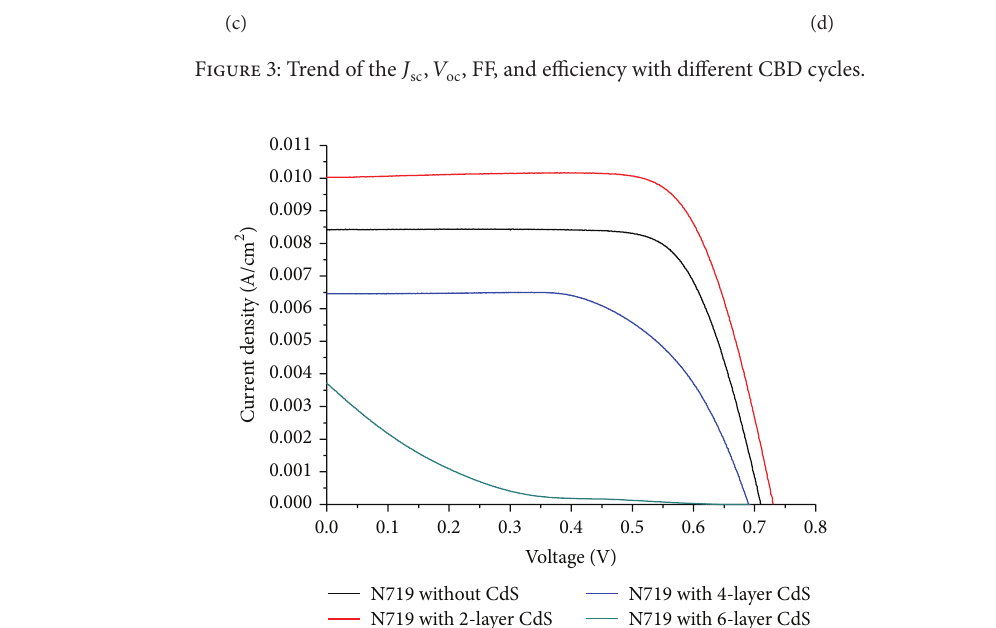
Figure 4: 𝐽 - 𝑉 curves of N719-sensitized DSSC and N719 and CdS cosensitized